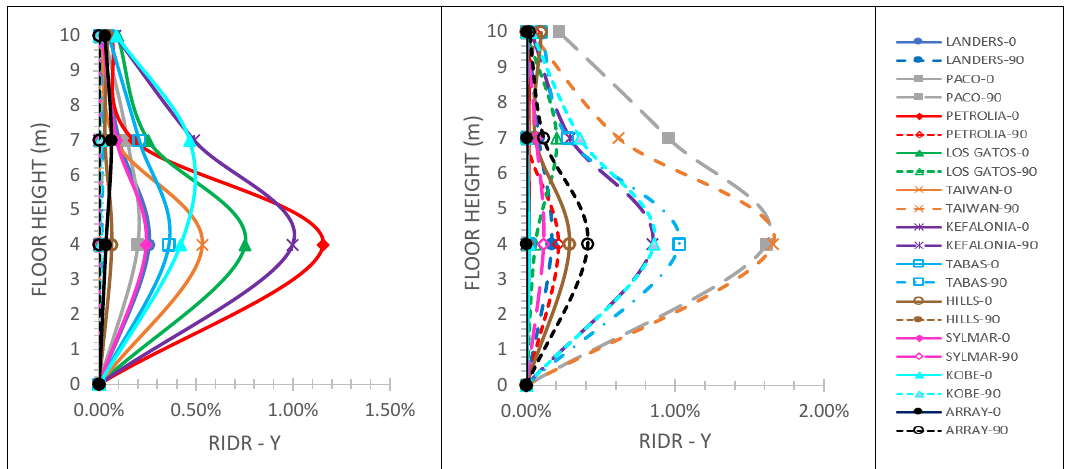
Figure 8. RIDR along X ( left ) and Y ( right ) horizontal directions of the three-story mixed building, considering the fixed-pinned connection of the steel structure to the r/c one.